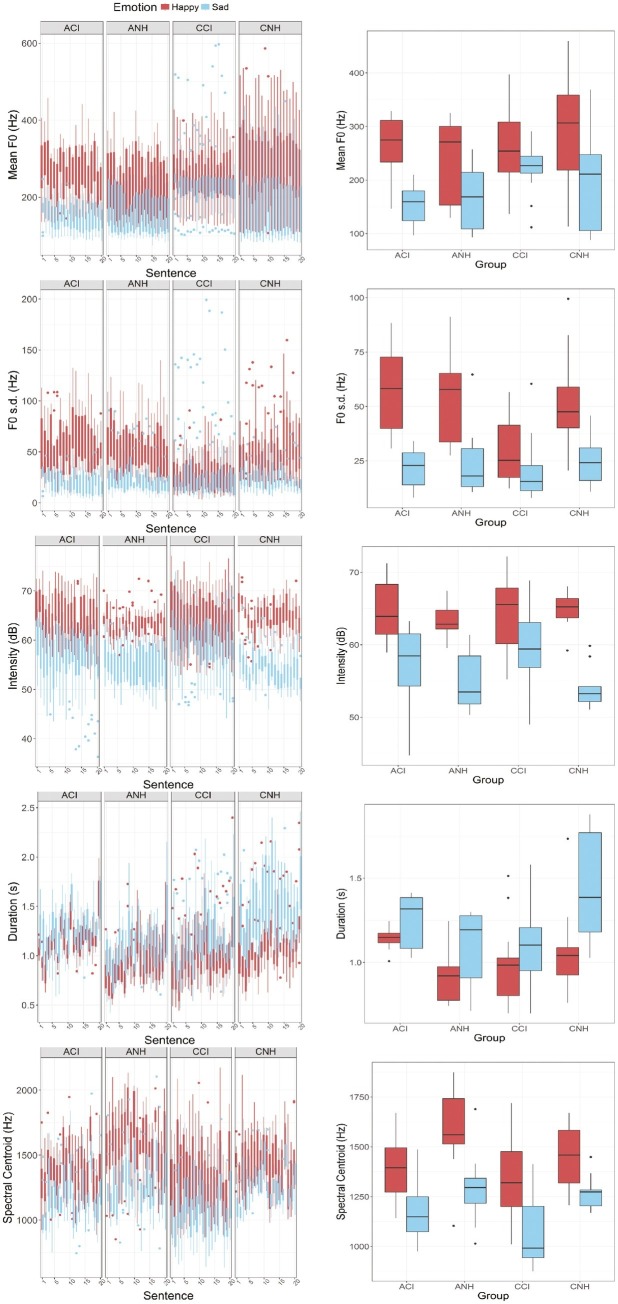
Group differences in acoustic features of emotional productions. (Top to bottom – left panels) These figures show boxplots of mean F0 (Hz), F0 s.d. (Hz), Intensity (dB), Duration (s), and Spectral Centroid (Hz) values estimated for each sentence (abscissa) recorded by the participants in each emotion (happy: red; sad: blue). Data from the four groups of participants are represented in the four panels (left to write: ACI, ANH, CCI, and CNH). (Top to bottom – right panels) These figures show boxplots of the mean values of these acoustic features computed across the 20 sentences recorded in each emotion by individual participants. The abscissa shows the four groups (ACI, ANH, CCI, and CNH). Happy and sad emotions are again shown in red and blue colors.